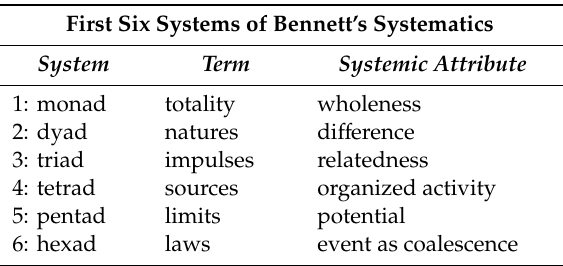
Table 3. The first six systems of Bennett’s systematics [9] (pp. 12–14, p. 111).